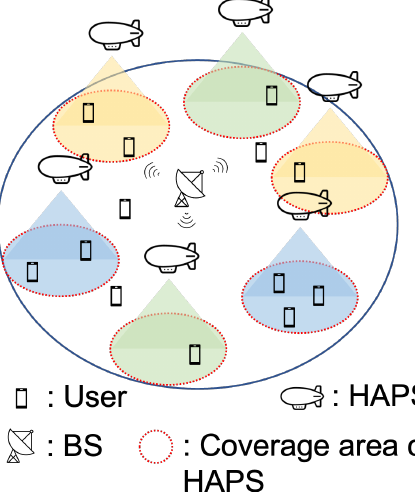
Figure 1. A HAPS system model.